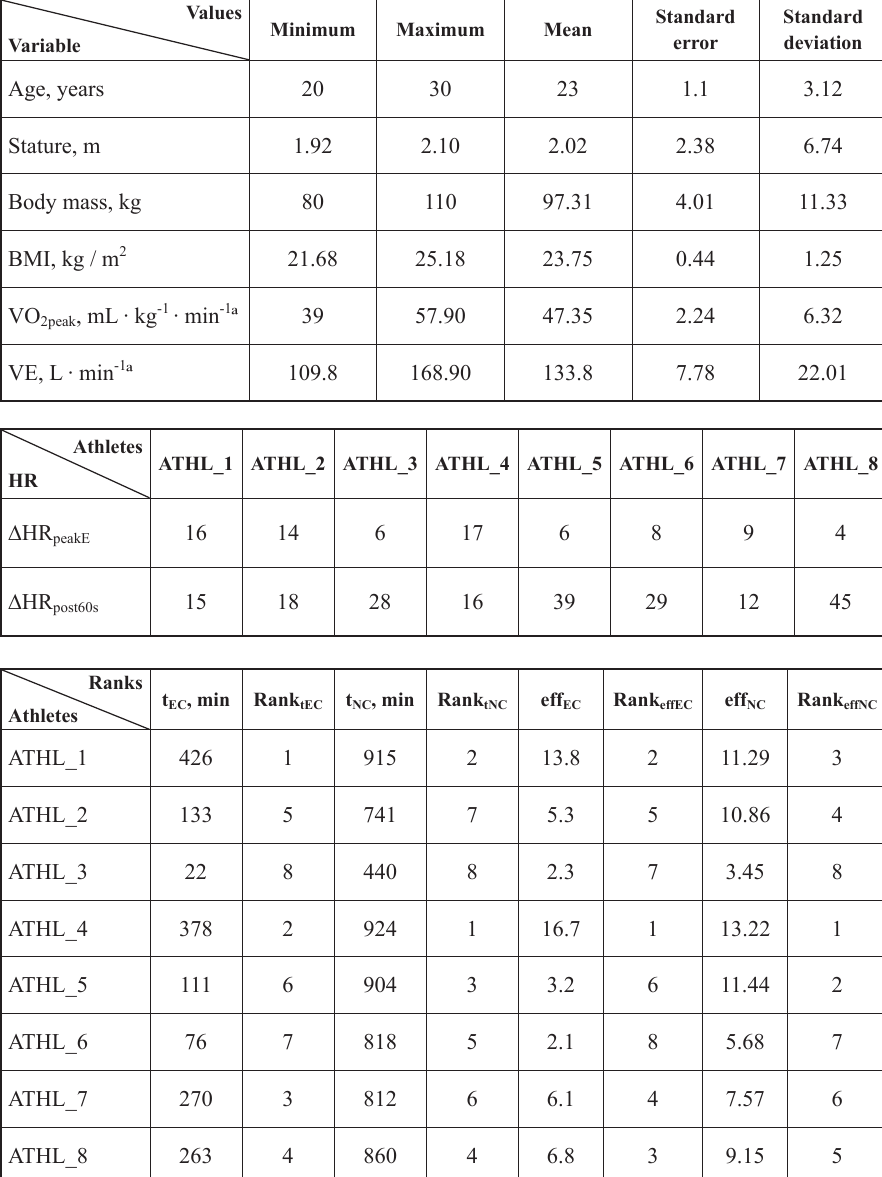
Table 3. Ranks of investigated athletes based on playing time and sport-speci fi c ef fi